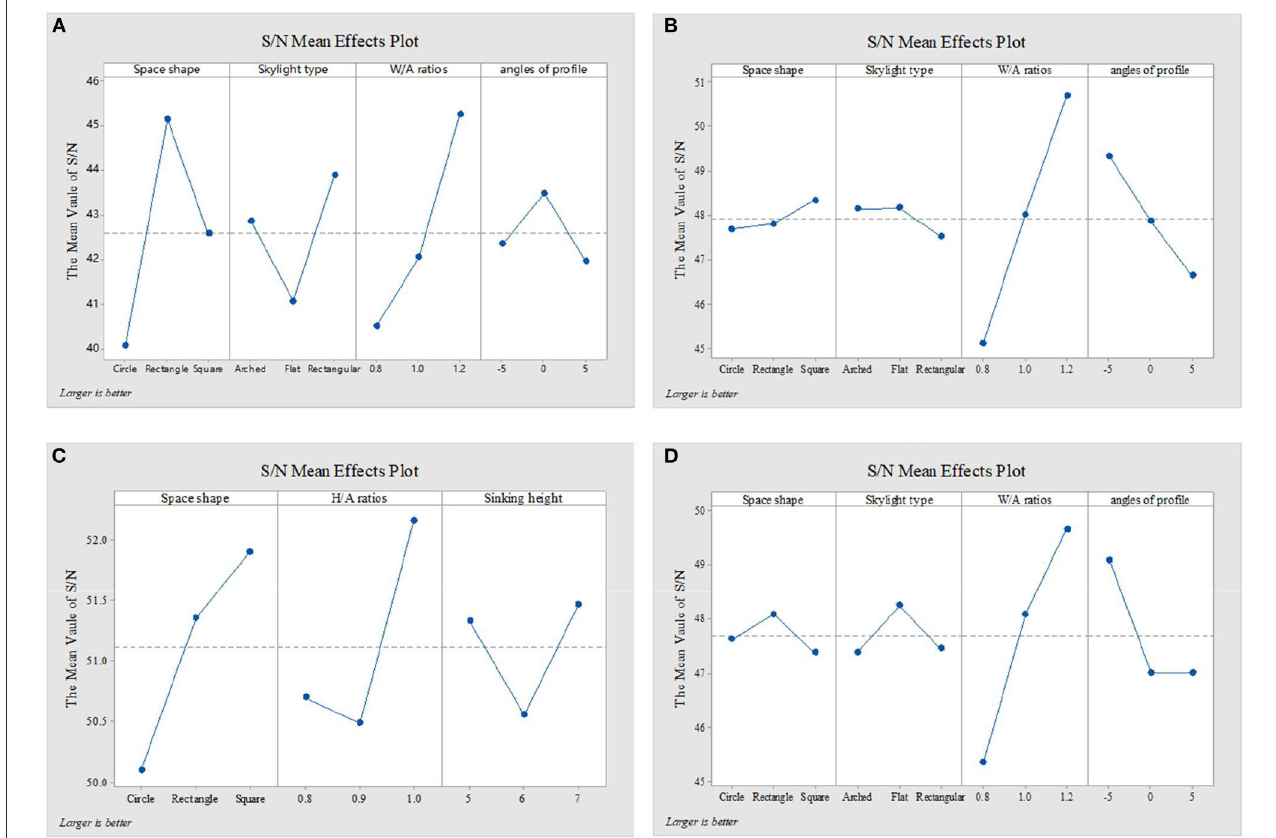
FIGURE9 Luminous environment response values for (A) TUAI, (B) TCAI, (C) TCSI, and (D) THAI. Image source: self-drawn by the